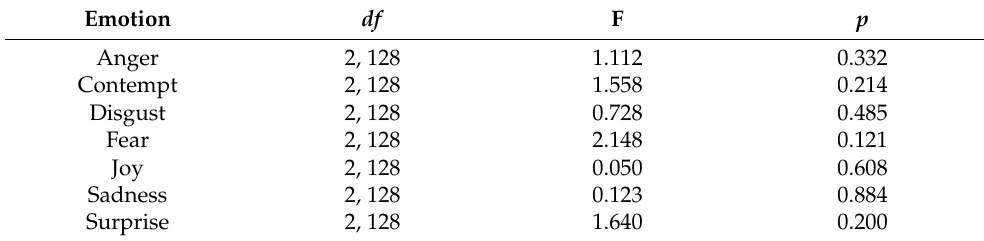
Joy Sadness 0.288 Surprise